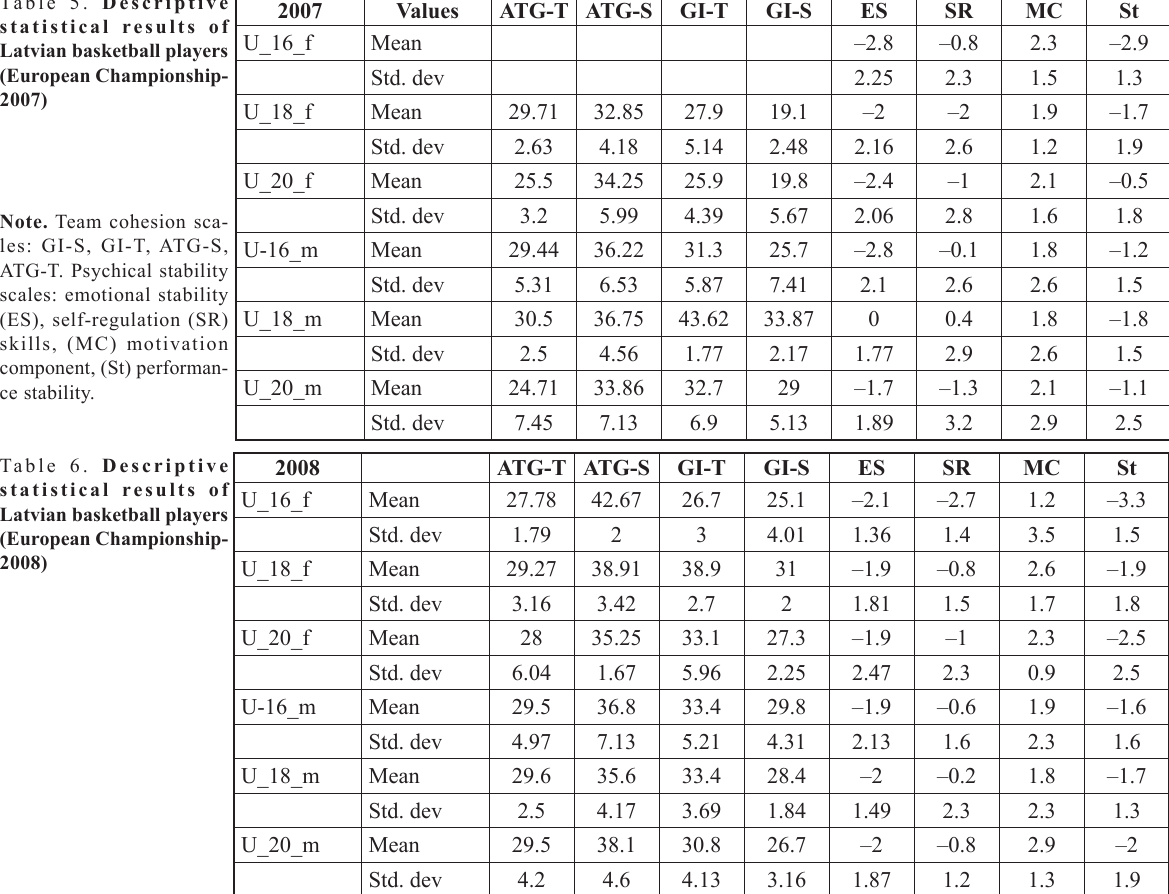
Table 5. Descriptive statistical results of Latvian basketball players (European Championship- 2007)